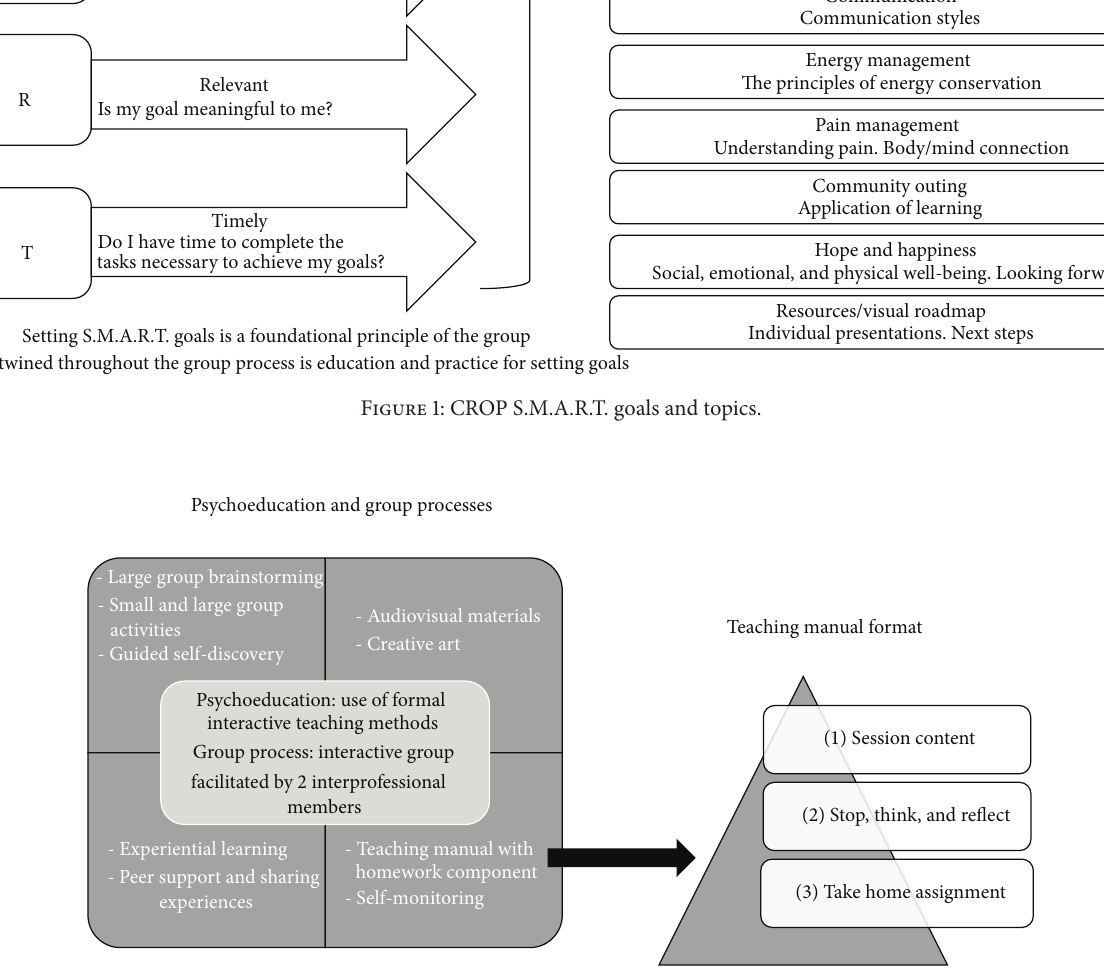
Figure 2: CROP processes and